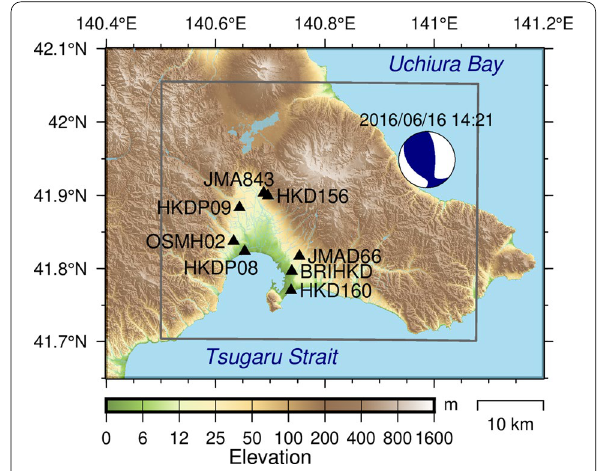
Fig. 10 Map showing the geographical area for the three-dimensional ground motion simulation (gray rectangle). The solid triangles represent strong motion stations used for waveform comparison. The moment tensor solution of F-net, NIED is plotted at the epicenter by the lower hemisphere projection